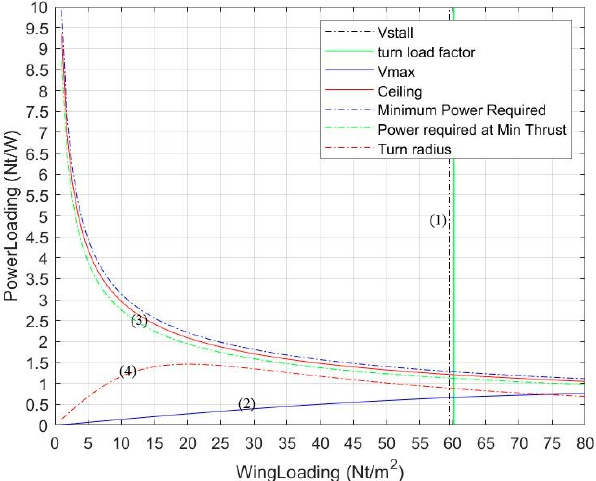
Figure 2. Matching plot for design of an experimental flying wing UAV.